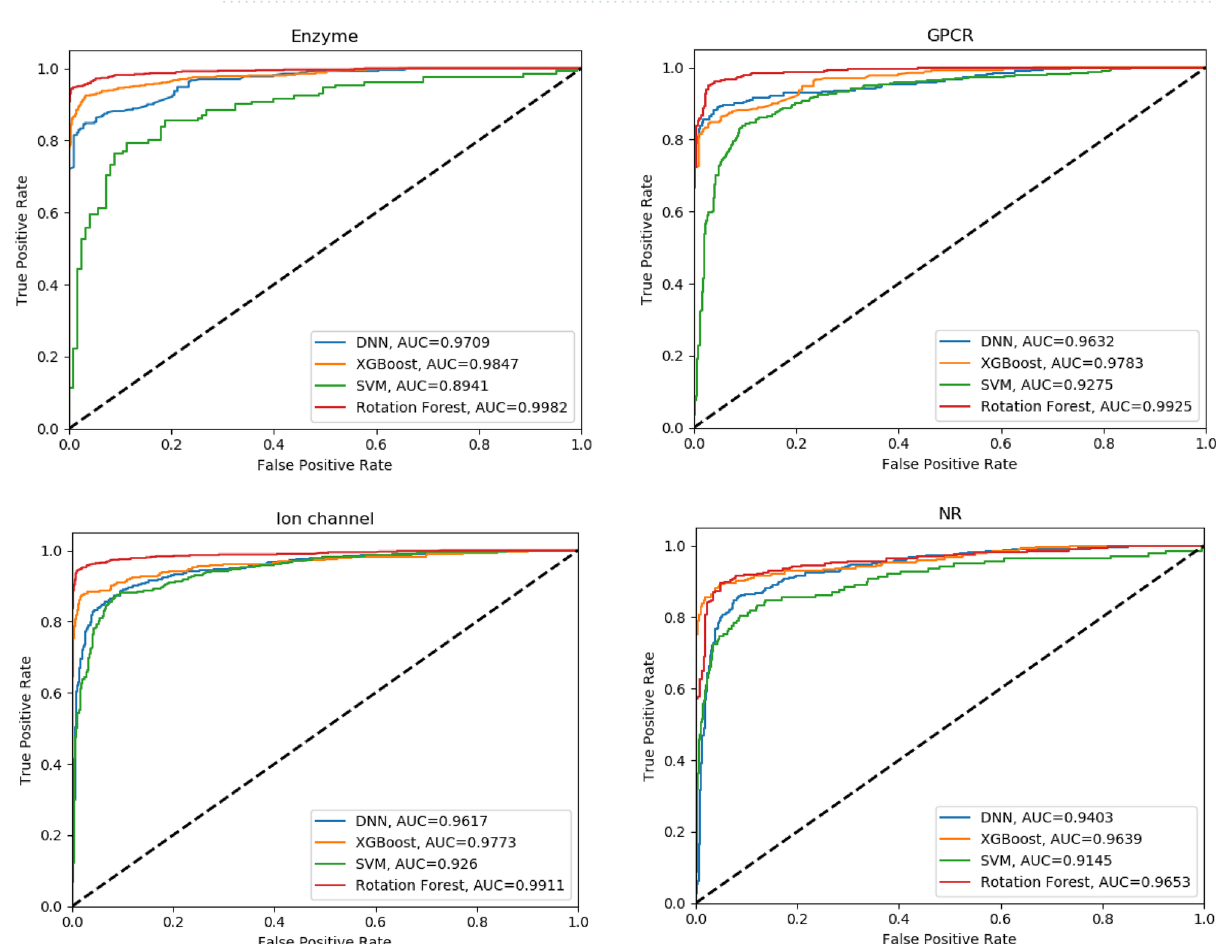
Figure 6. ROC curves of different classifiers on the data